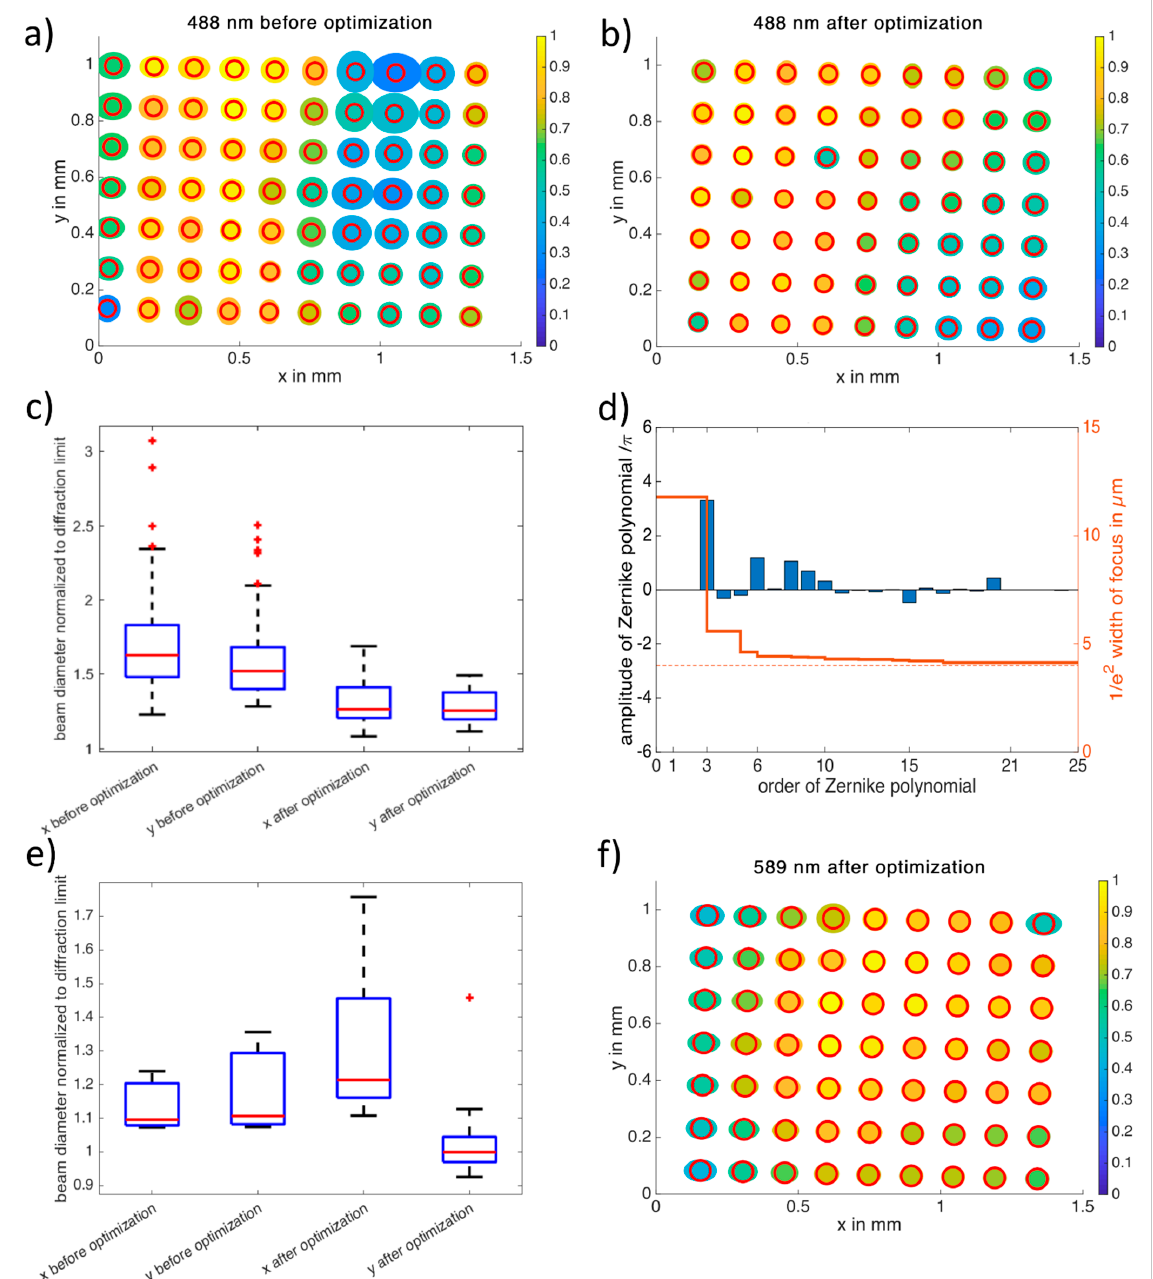
Figure 3. Single focus features over the field of view. Top row: 488 nm beam path D 4 σ focus diameters along the major axes of measured astigmatic beams according to ISO 11146. ( a ) before correction of system aberrations. ( b ) after aberration correction. Red circles indicate the theoretical diffraction limit of Gaussian beams (see Equation (6)). Color encodes relative brightness. Focus sizes are not to scale. ( c ) 488 nm foci summarized as boxplots. Beam diameters normalized to diffraction limit of a Gaussian beam before and after correction of system aberrations. ( d ) example of the contribution of individual Zernike polynomials to the optimization of system aberrations of the 488 nm beam in the center of the field of view. Dashed line marks the 1/e 2 diffraction limit of an Airy disc (see Equation (8)). ( e ) 589 nm foci summarized as boxplots. Beam diameters normalized to diffraction limit of a Gaussian beam before and after correction of system aberrations. ( f ) 589 nm D 4 σ focus diameters along the major axes after aberration